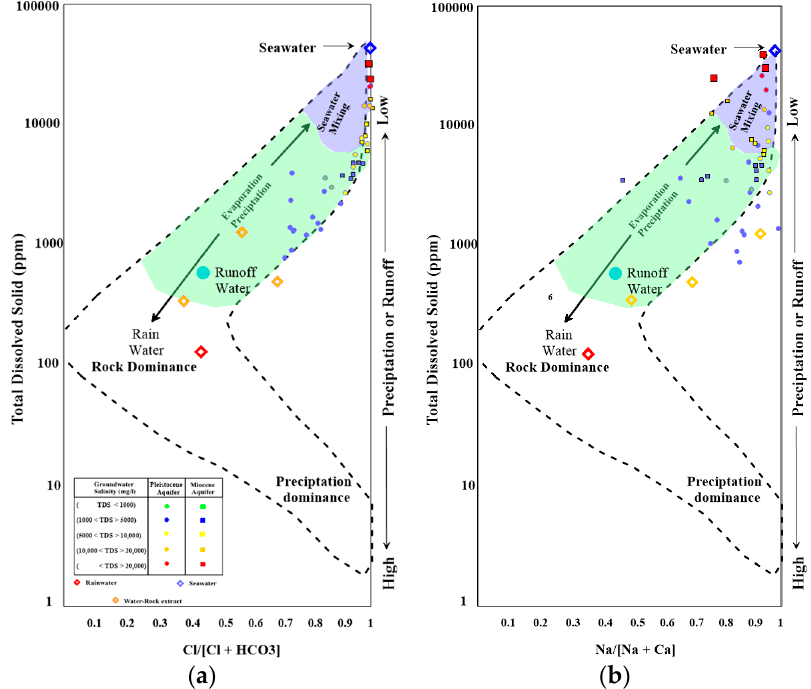
Figure 4. Gibbs diagram for the groundwater wells tapping the Pleistocene and Miocene aquifers; ( a ) Total dissolved solids (TDS) versus Cl/[Cl+HCO 3 ]; ( b ) TDS versus Na/[Na+Ca].